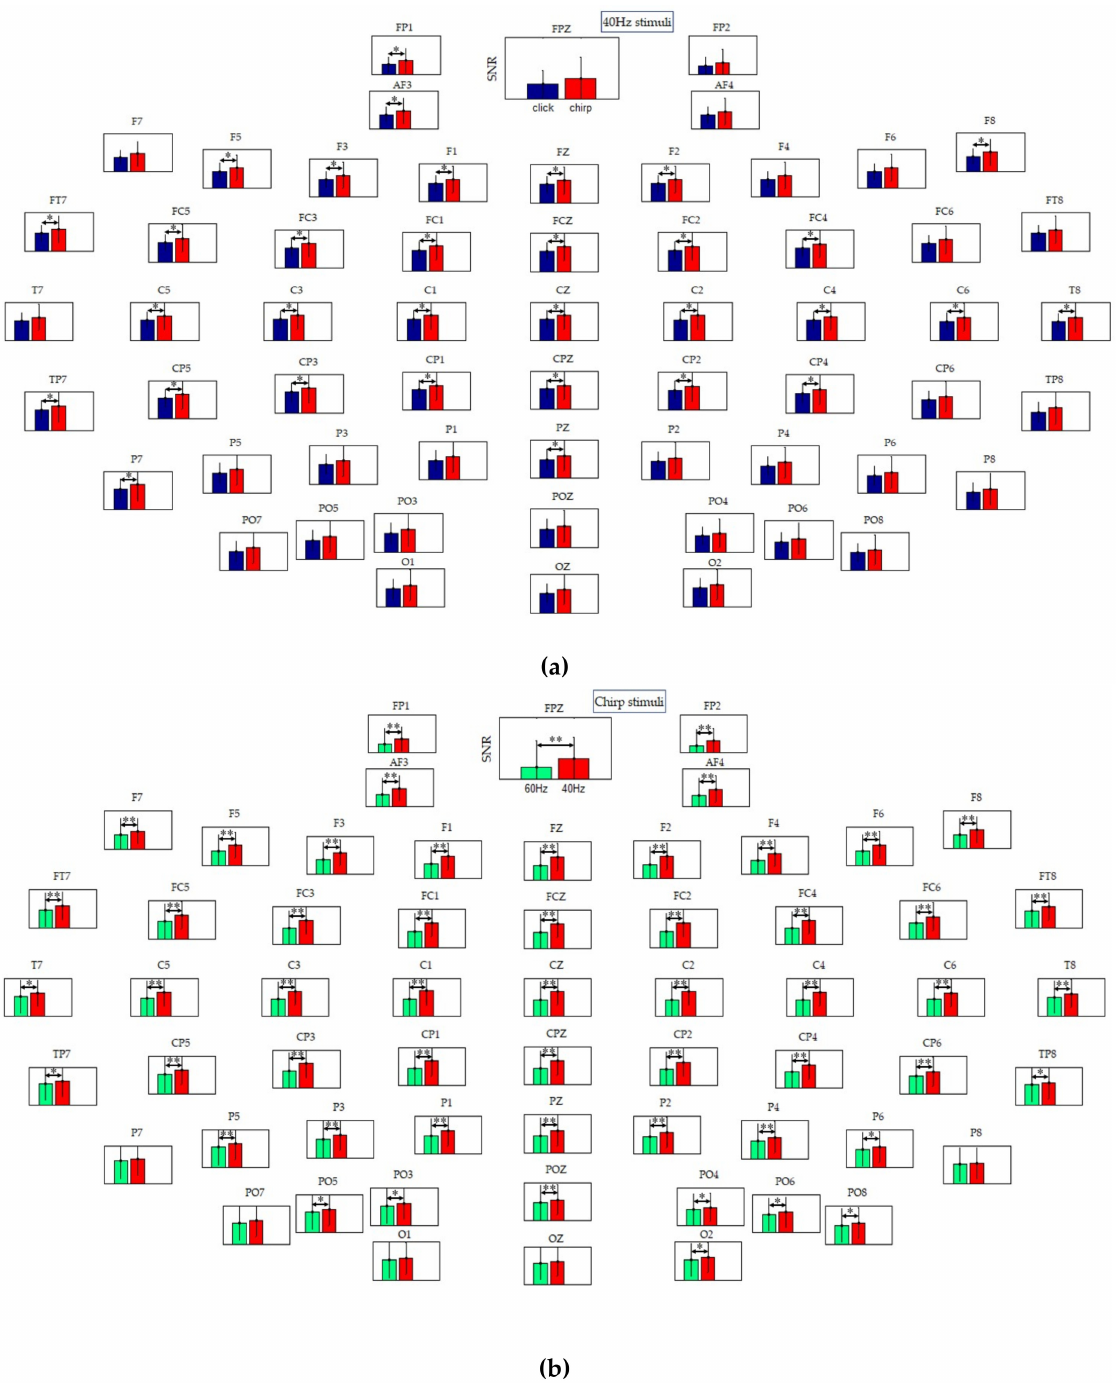
Figure 7. Mean SNR histogram at each lead across 20 subjects: ( a ) the mean SNR histogram of 40 Hz chirp stimulus and 40 Hz click stimulus; ( b ) the mean SNR histogram of 40 Hz chirp stimulus and 60 Hz chirp stimulus; * represents P ≤ 0.05, ** represents P ≤